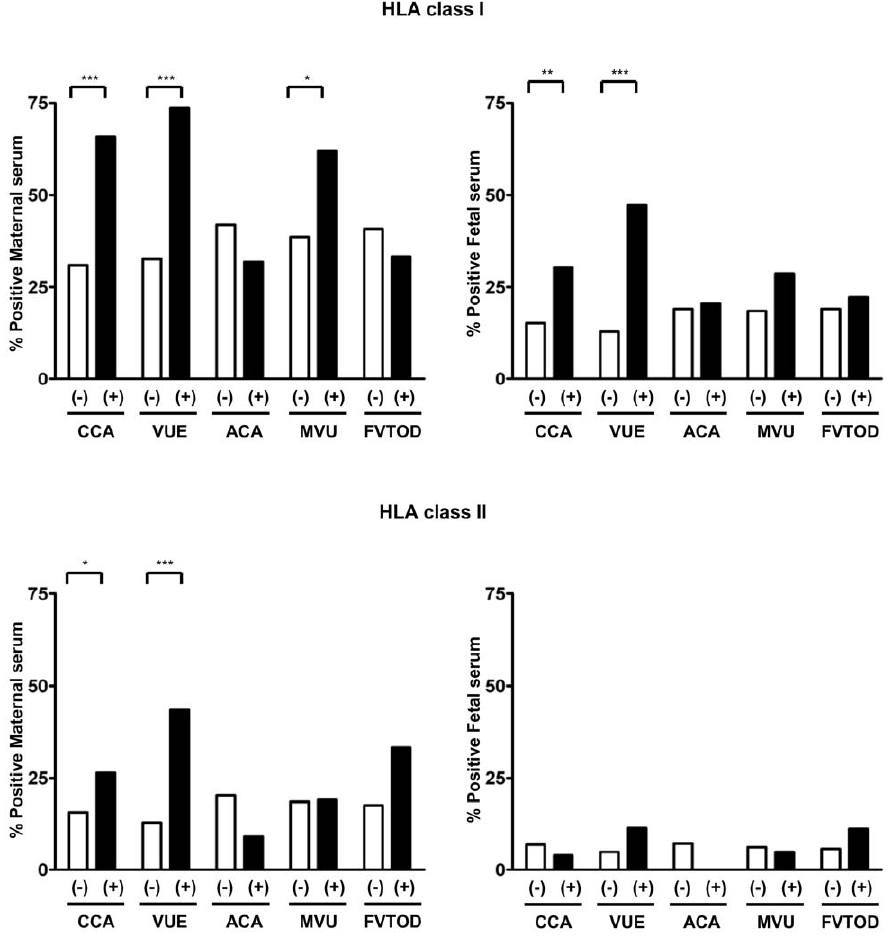
Figure 3. Comparisons of maternal and fetal panel-reactive anti-HLA class I and II seropositivity according to presence or absence of placental pathologic lesions. Maternal anti-HLA class I and class II seropositivity and fetal anti-HLA class I seropositivity is higher in chronic chorioamnionitis cases than those without chronic chorioamnionitis (p , 0.05, for each). Similarly, maternal anti-HLA class I and class II seropositivity and fetal anti-HLA class I seropositivity is higher in villitis of unknown etiology cases than those without (p , 0.001, for each). Such differences in anti- HLA seropositivity are not found in the cases with acute chorioamnionitis, maternal vascular underperfusion, and fetal vascular thrombo-occlusive disease except for maternal anti-HLA class I seropositivity in cases with maternal vascular underperfusion (p , 0.05). CCA , chronic chorioamnionitis; VUE , villitis of unknown etiology; ACA , acute chorioamnionitis; MVU , maternal vascular underperfusion; FVTOD , fetal vascular thrombo-occlusive disease. *, p , 0.05; **, p , 0.01; ***, p , 0.001.